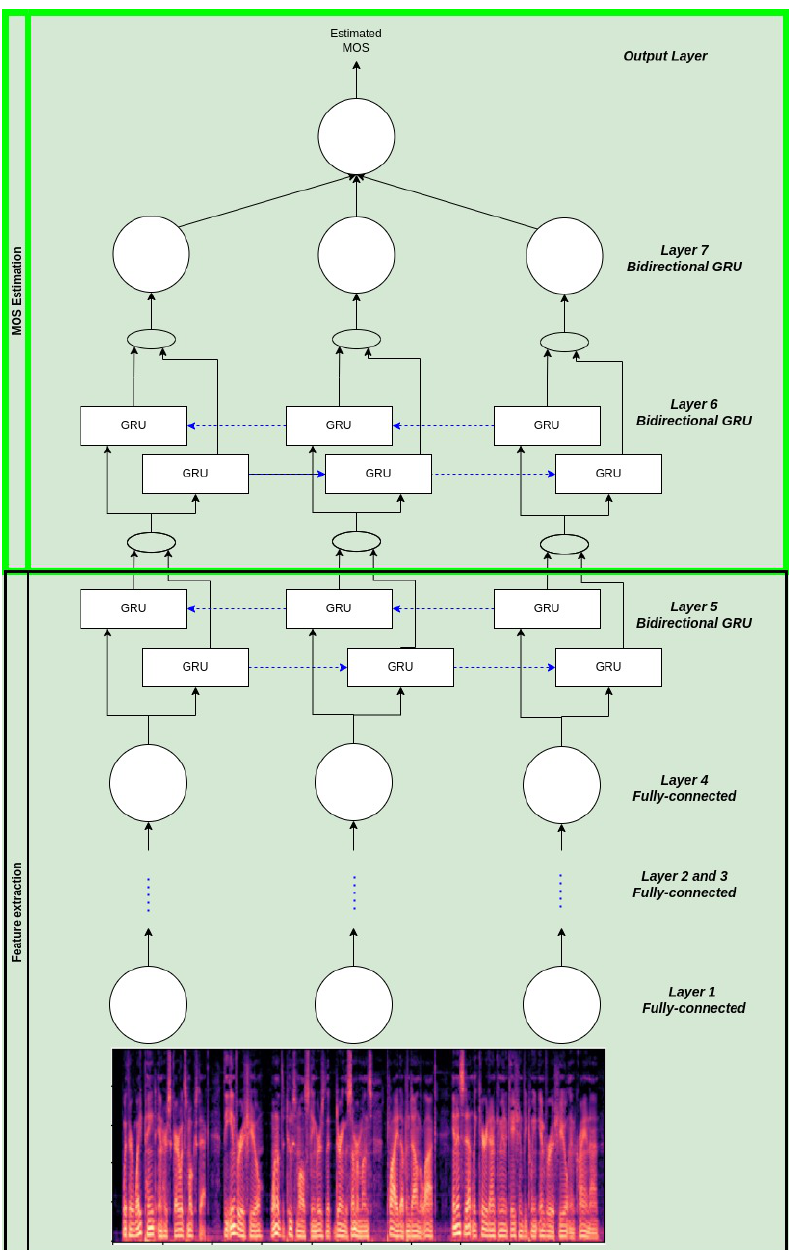
Figure 1. Proposed model network